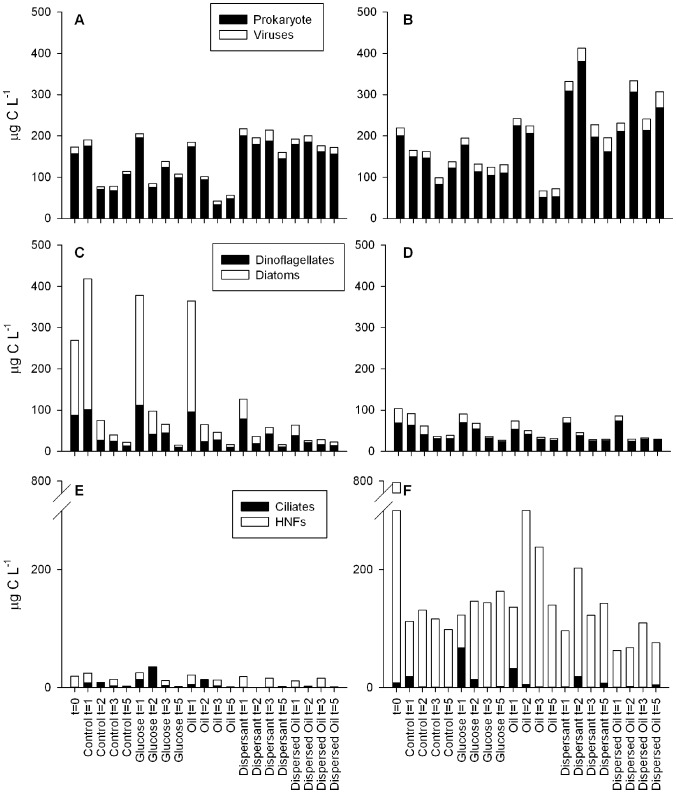
Distribution of carbon in the six microbial groups over time for each of the five treatments.Values shown are averages for the five replicates. Values from the June experiment are shown on the left for Prokaryotes and Viruses (A), Dinoflagellates and Diatoms (C) and Ciliates and HNFs (E). August values on the right (B, D and F). In June (E), HNF values were not obtained at t-2 and 5 d, but all data was collected for August (F).